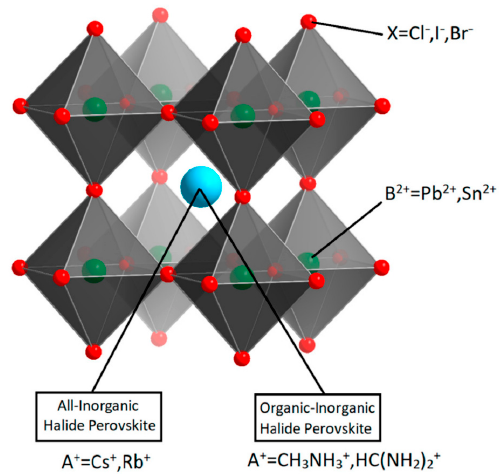
Figure 1. Schematic diagram of ABX 3 halide perovskite crystal structure. Reproduced from [22] © Permission according to Creative Commons Attribution License.